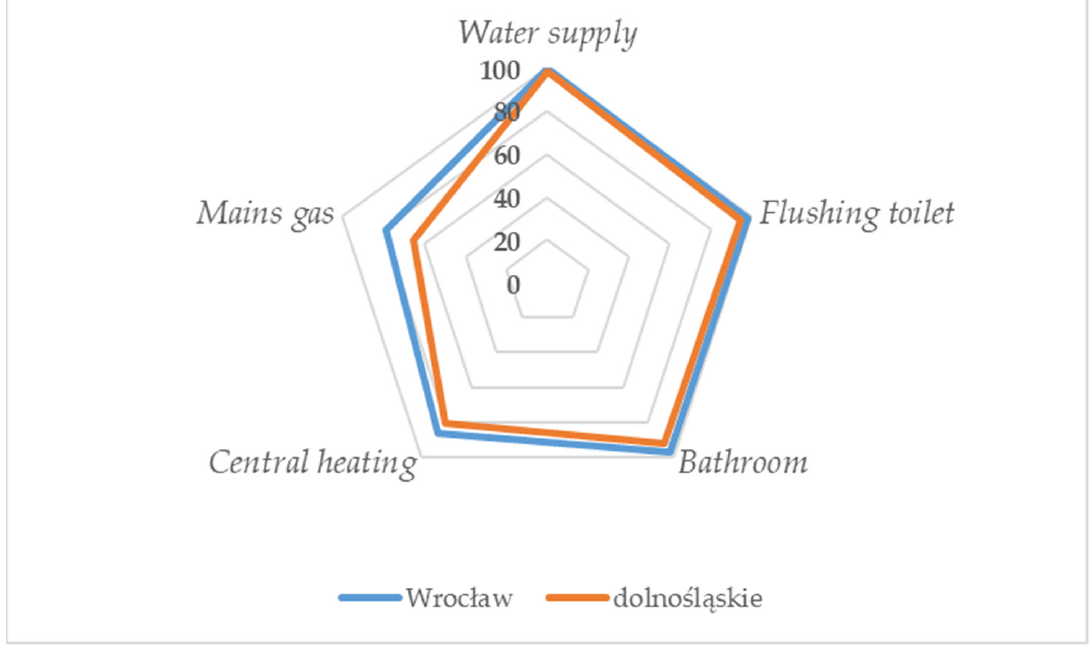
Figure 17. Indicators of housing infrastructure quality in Wroc ł aw and the Lower Silesian Province.